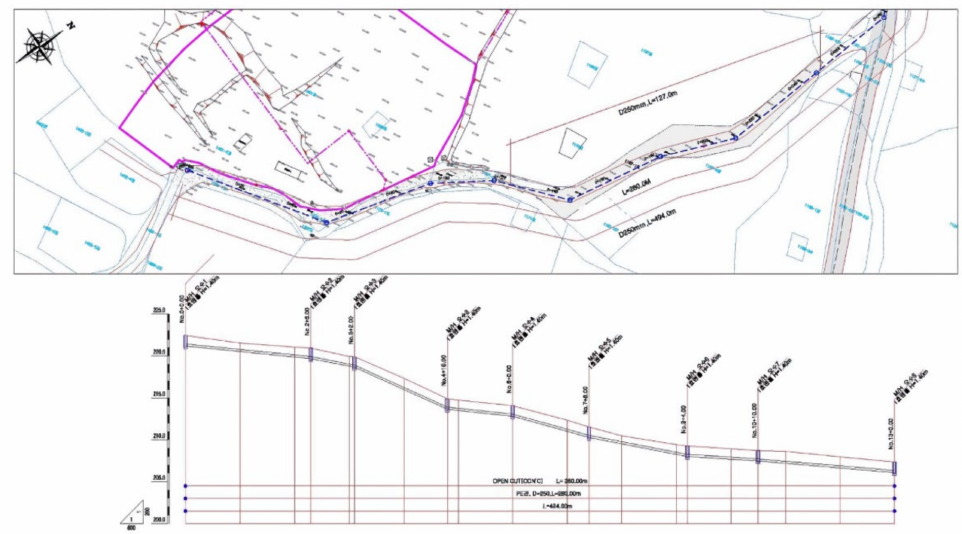
Figure 6. An example of the slope information collected from the Road Management System